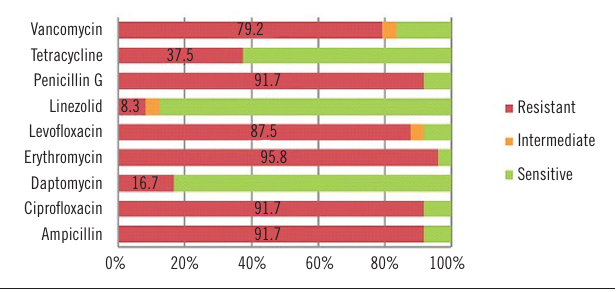
figurE − Susceptibility profile of Enterococcus faecium The red bar represents the percentage of antimicrobial resistance, the orange bar indicates the intermediate profile and the green bar represents the percentage of